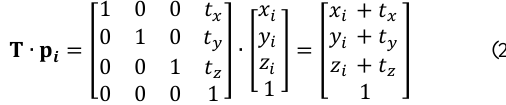
Figure 2: The area of interest is highlighted by a red polygon while four applied tie points are marked by yellow rectangles While only one measurement was conducted with the TLS per epoch, continuous acquisition has been carried out by the TRS. The measurements were interrupted when geometric changes have been made in the area of interest. The according measuring plan is depicted in Figure 3 where the time between epochs was about 15 minutes.